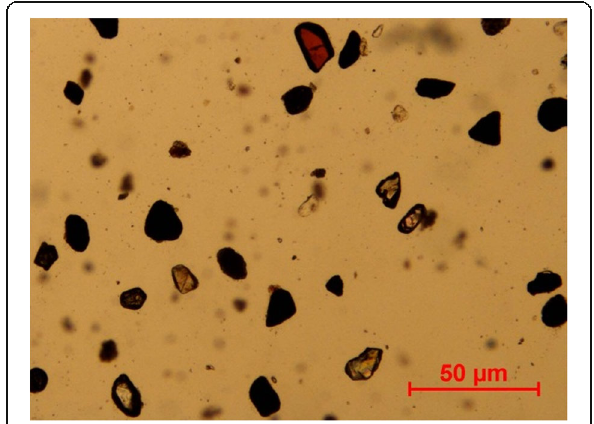
Fig. 9 Heavy fraction composed of opaque ’ s (black), zircon (zoned colorless euhedral to subhedral grains), and staurolite (reddish brown at the upper left corner), heavy fraction, PPL. × 100